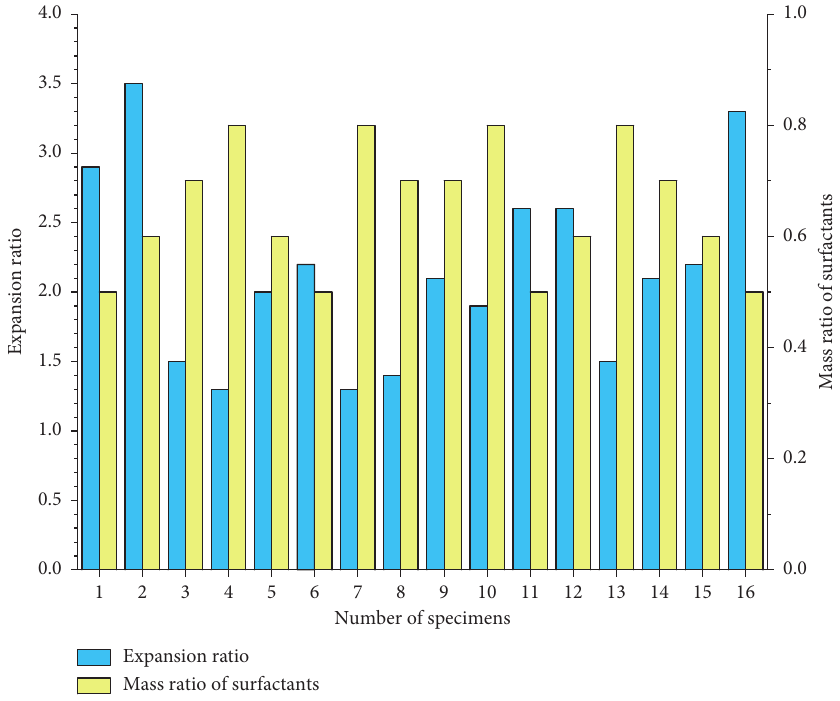
Figure 9: Relationship of surfactants with foaming